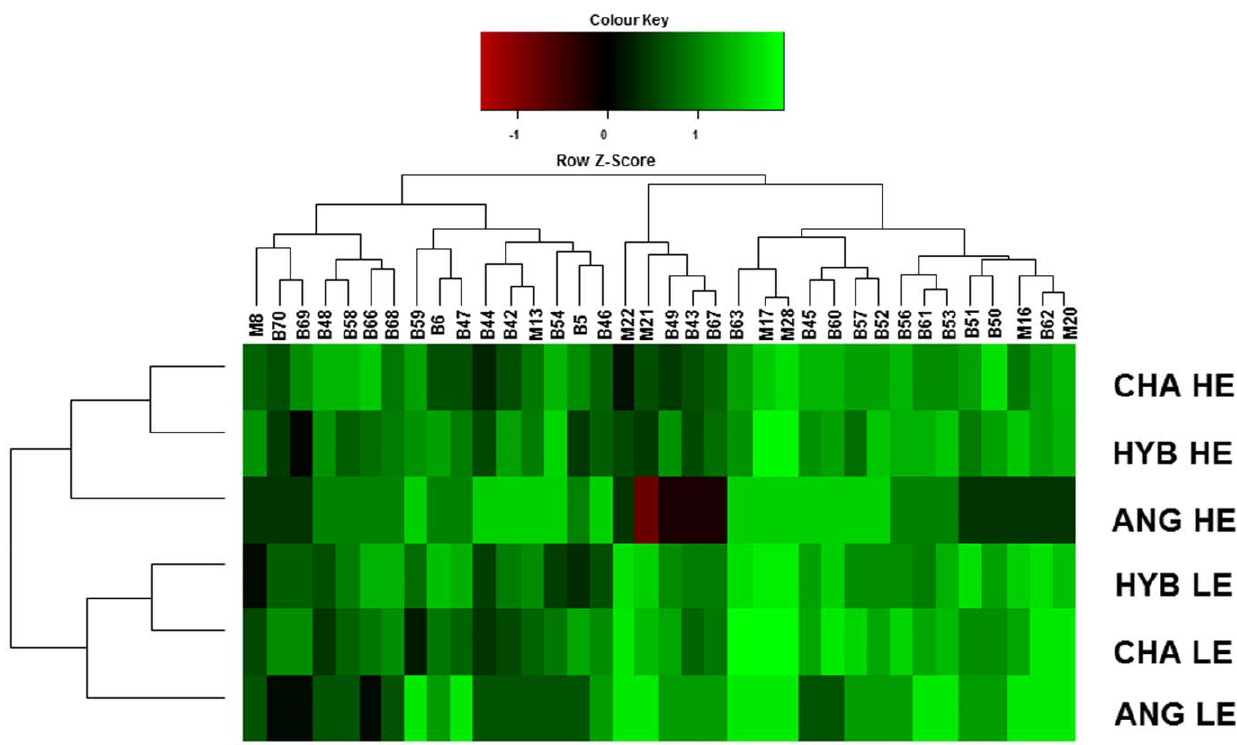
Figure 3. Heat map of correlations between frequencies of bacterial and methanogen phylotypes and their relationship with diet (LE/HE) and sire breed (ANG, CHA, HYB). Each square represents the Spearman’s correlation coefficient between the frequencies of the phylotype in the column with the frequency of the phylotype in the row. Order of phyltypes is determined as in a hierarchical cluster analysis. Self- correlations are identified in dark